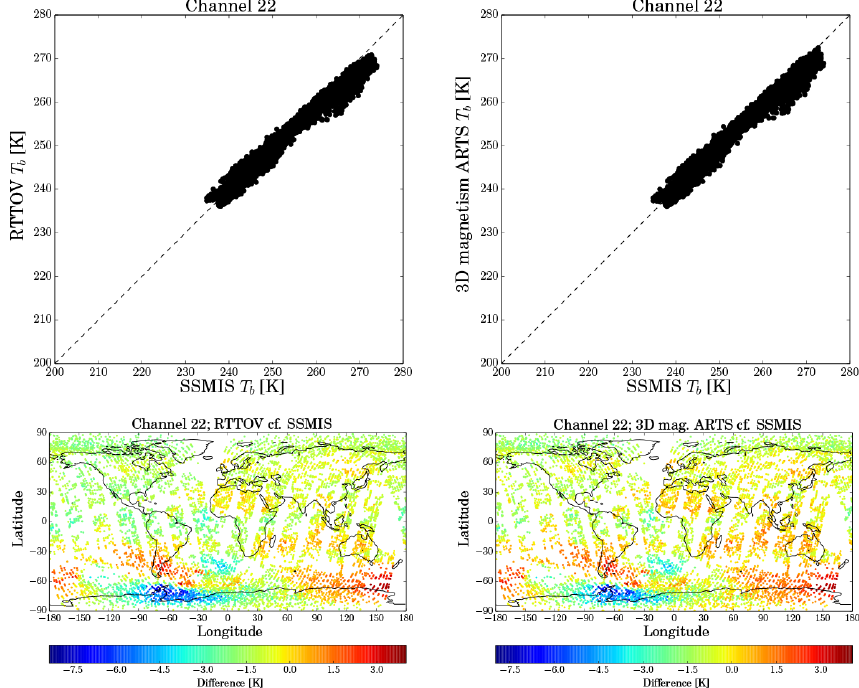
Figure 11. Comparison of model simulations and SSMIS measurements for channel 22 as for Fig. 10.